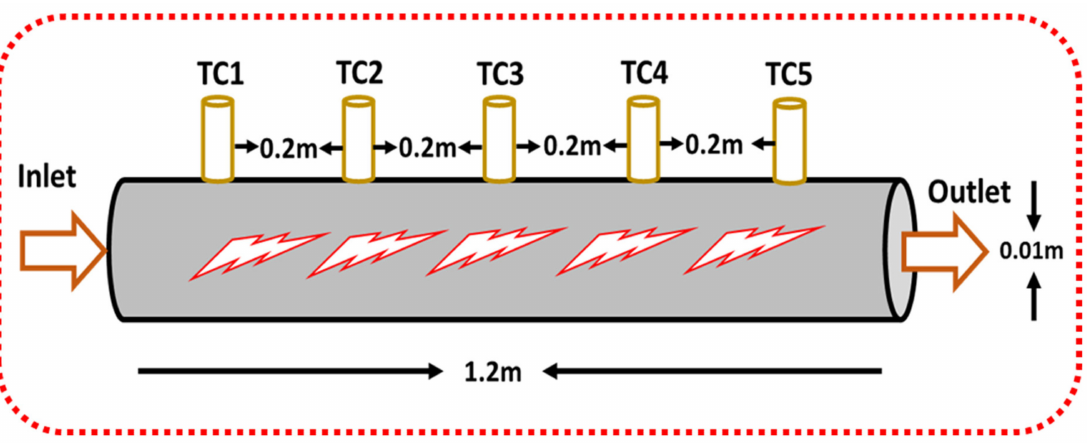
Figure 2. The 2-D geometric model of the circular heat